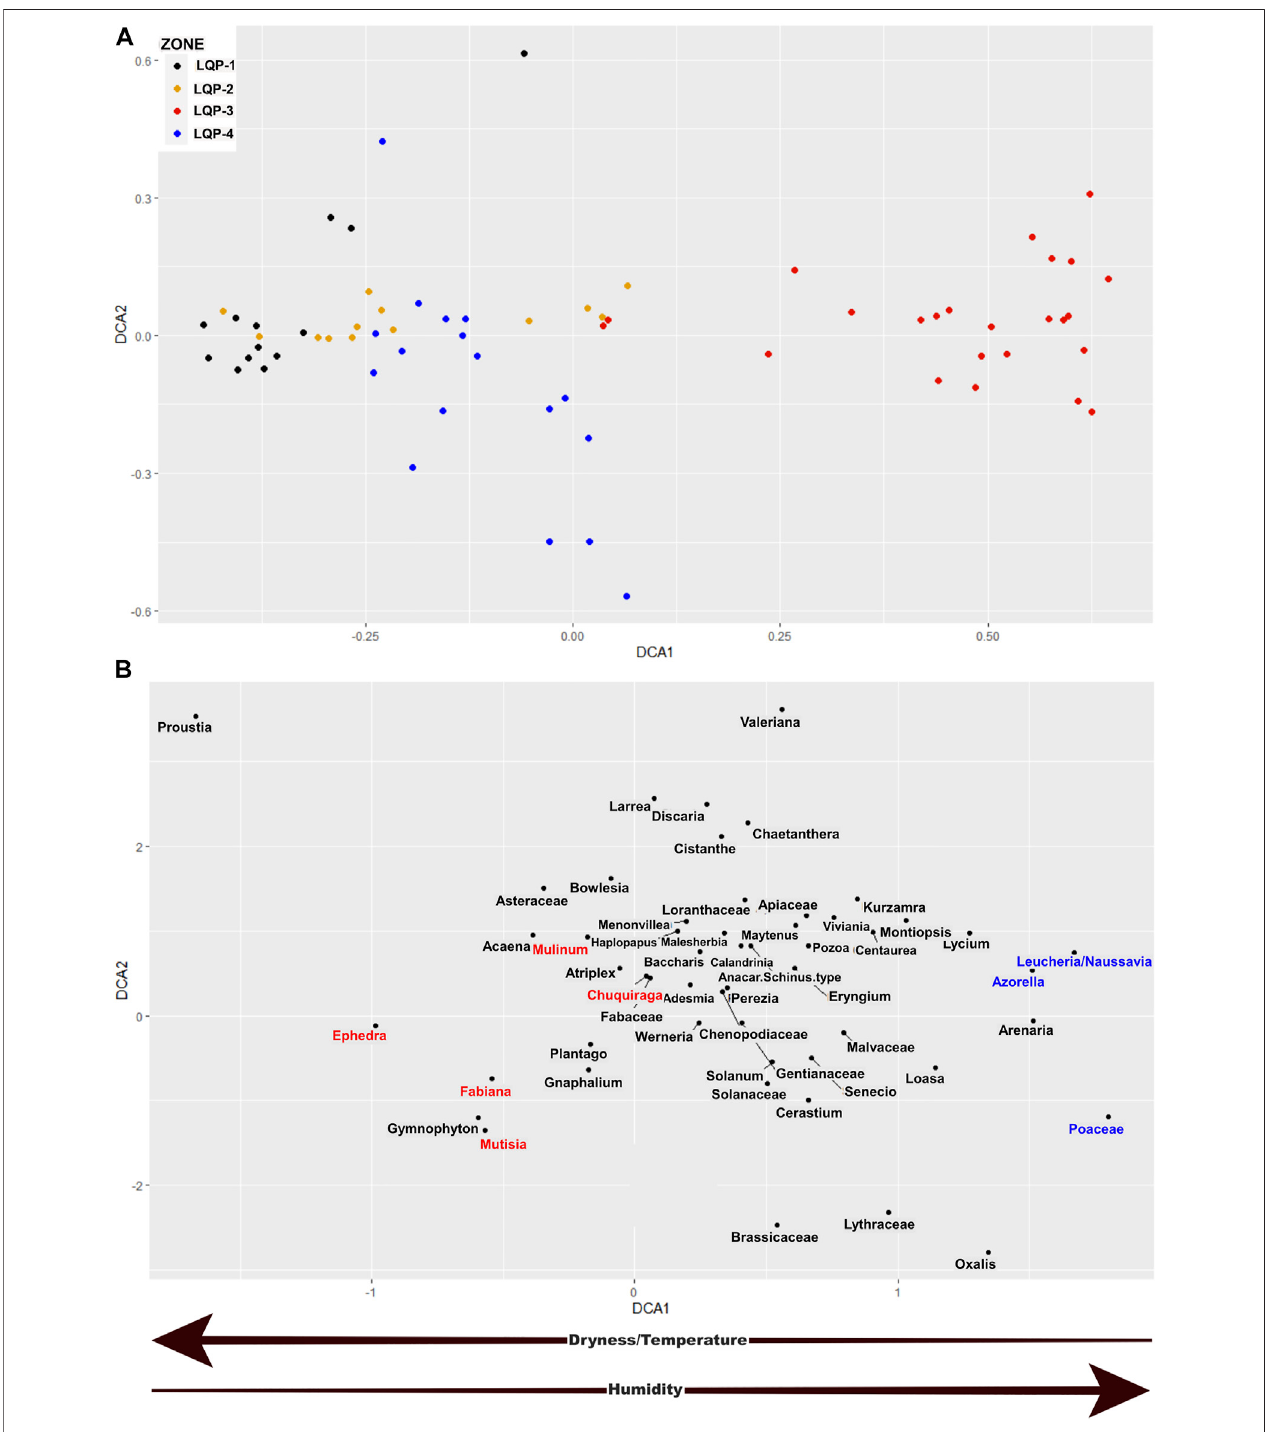
FIGURE 7 | DCA results from the pollen abundance of Laguna Quebrada Parada. (A) Ordering of the levels (colored points) grouped in the zones, obtained by the cluster analysis; on the left, are the levels with environmental conditions of lower humidity and on the right, the levels with higher humidity. (B) Ordering of pollen types, with a similar arrangement in the multivariate space as the levels. Pollen types related to warmer and less humid conditions are highlighted in red. Pollen types related to cool and humid conditions are highlighted in blue. The arrows below indicate how the humidity and temperature conditions vary along the DCA 1 axis.